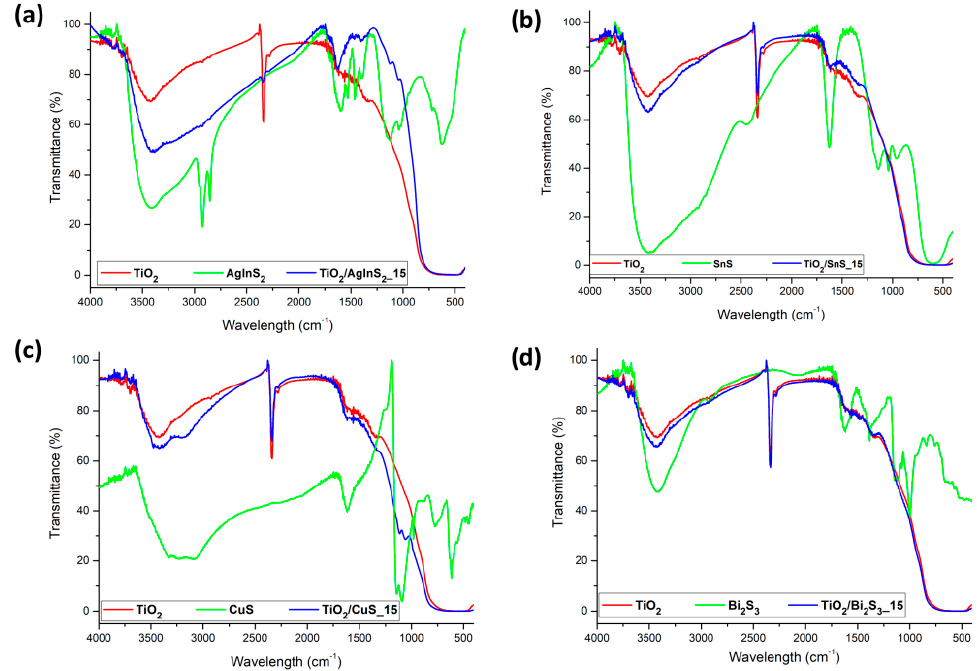
Figure 6. FT-IR spectra for QDs and TiO 2 modified by ( a ) TiO 2 , AgInS 2 and TiO 2 /AgInS 2 _15, ( b ) TiO 2 , SnS and TiO 2 /SnS_15, ( c ) TiO 2 , CuS 2 and TiO 2 /CuS_15, ( d ) TiO 2 , Bi 2 S 3 and TiO 2 /Bi 2 S 3 _15.